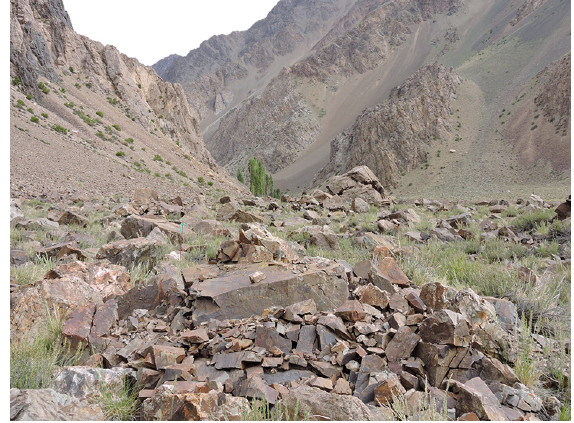
Figure 2. Photograph of rocky outcrops used by the Phymaturus palluma in Punta de Vacas Valley, Mendoza,